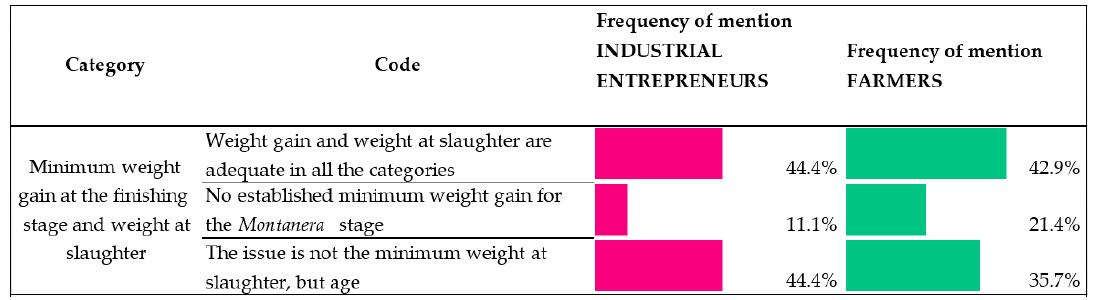
Figure 3. Industrial entrepreneur / farmer views on the requirements of the QS (Quality Standard) in terms of weight gain at the finishing stage and minimum weight at slaughter. (Scale: frequency of mention of each opinion. Percentage is based on responses in the given code out of all responses to equal 100%).